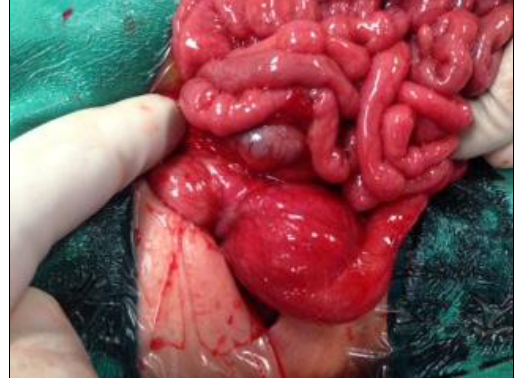
Figure 1: Case 1- showing preduodenal portal vein crossing anterior to the dilated duodenum. The duodenum beyond level of PDPV is also dilated indicating non-obstructing type of